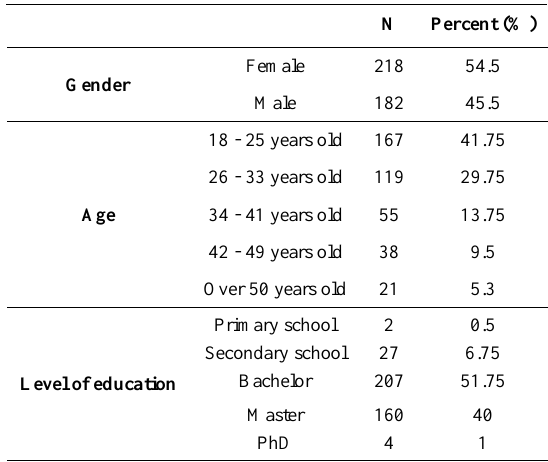
Table 1. Respondent Characteristics; Note: